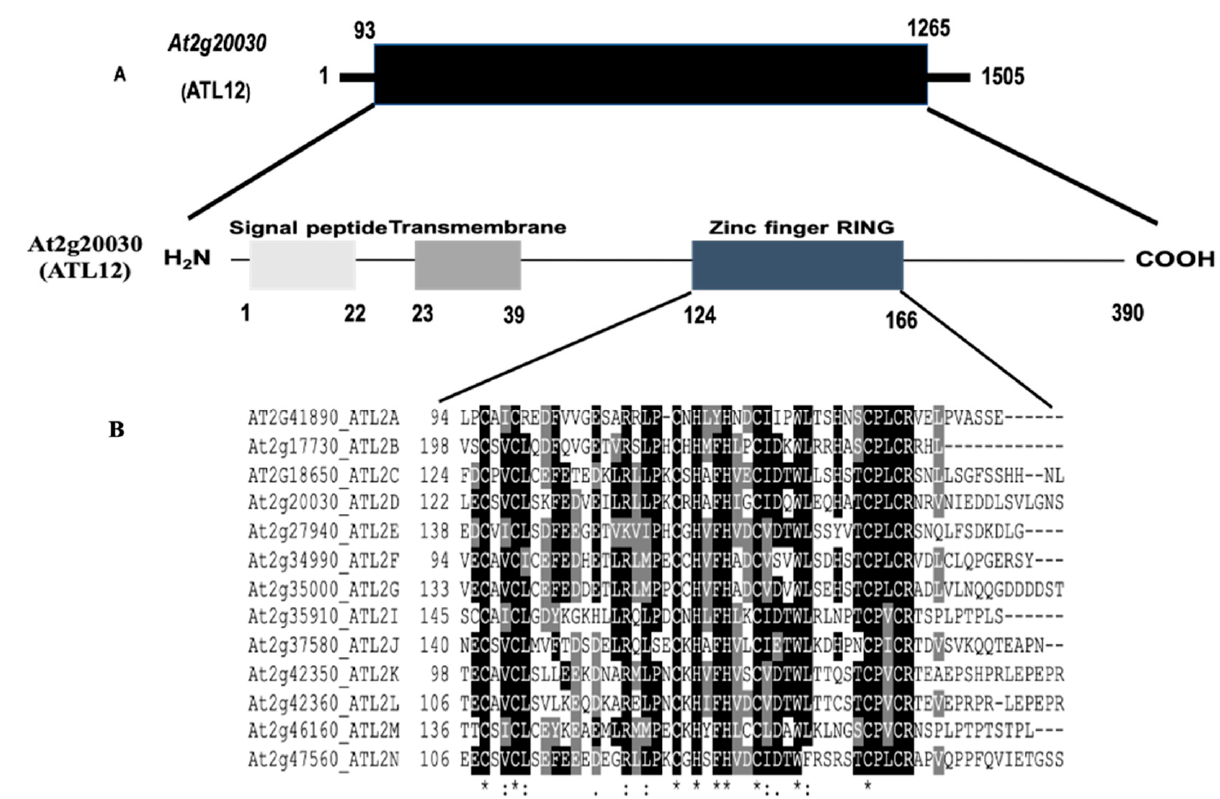
Figure 1. Sequence and domain analysis of ATL12 . ( A ) The structure of genes and predicted domains for ATL12. One transmembrane domain (TM); and a C3HC4 RING Zinc-finger domain. ( B ). The consensus sequence for this group of RING zinc-fingers is C-X2-CL-X-E-X7-R-X2-P-X-C-X-H-X-FH-X2-C-X-D-X-W-X6-CP-X-C, where X is any amino acid. * indicates perfect alignment; : indicates a site exhibiting strong similarity; . indicates a site exhibiting weak similarity.